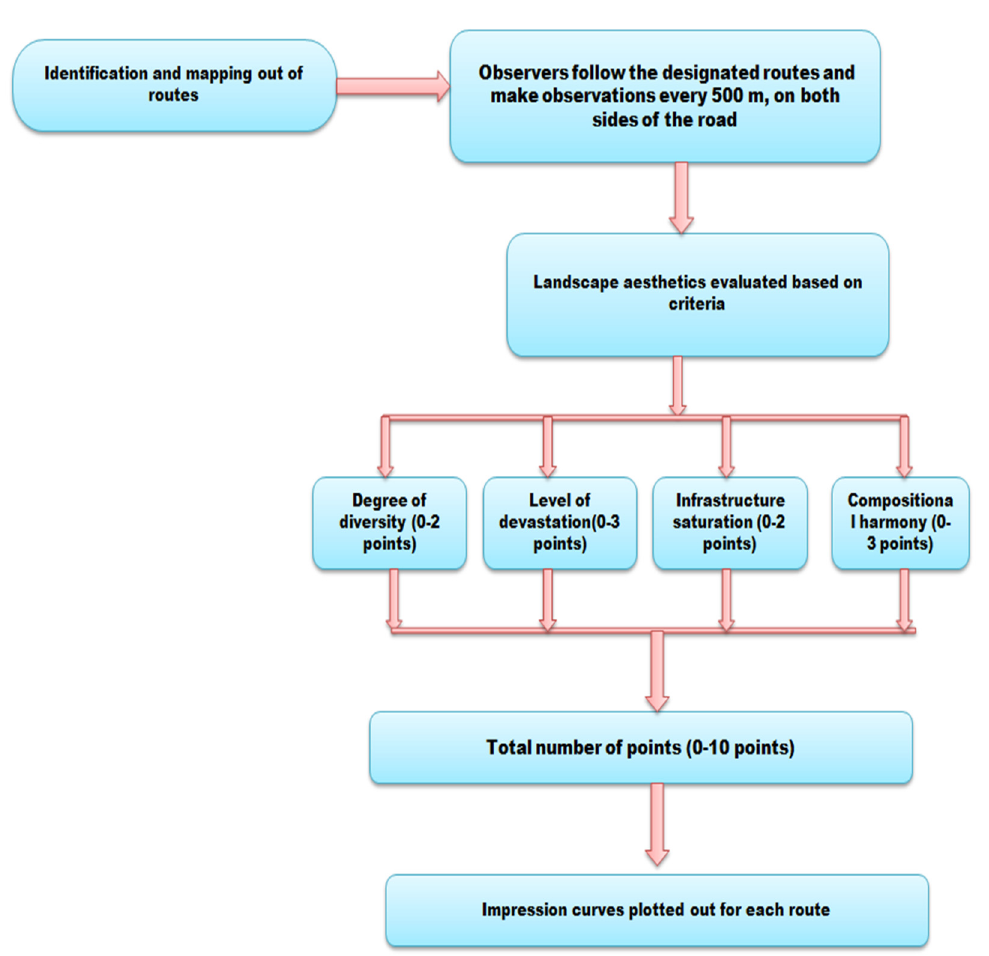
Figure 3. Flow-chart illustrating the application of Wejchert’s [27,28,30] impression curve